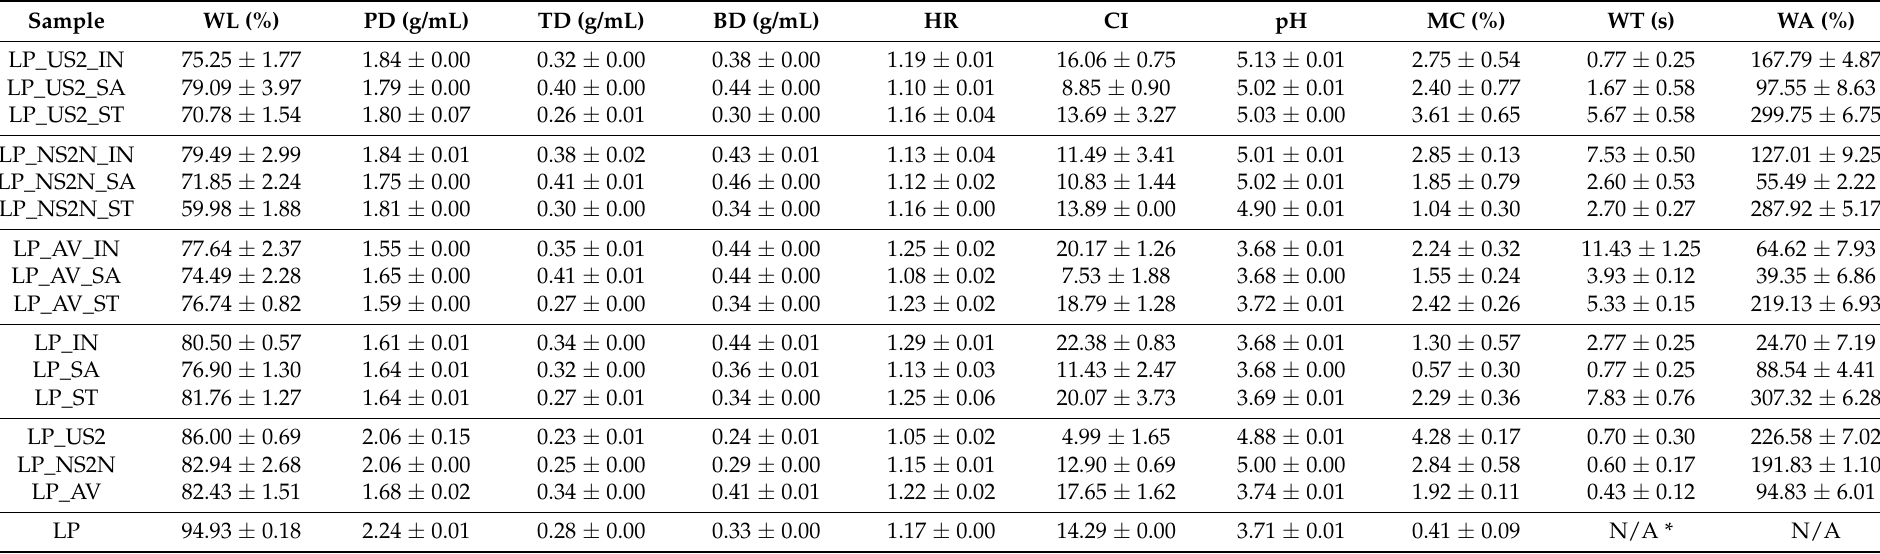
Table 2. Weight loss (WL) after the freeze-drying process; physicochemical properties of the lyophilized sample (pycnometric density (PD); bulk density (BD); tapped density (TD); Hausner ratio (HR); Carr’s compressibility index (CI); pH leaching; moisture content (MC); wetting time (WT); water absorption ratio (WA)) ± calculated